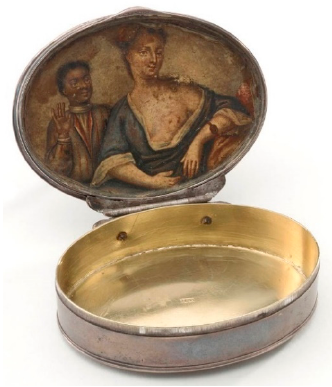
Figure 9. William Hutchinson, snuffbox. Silver glazed, ivory; 24 mm × 75 mm × 58 mm (ZBA2452). National Maritime Museum, Greenwich, London, Michael Graham-Stewart Slavery Collection. © National Maritime Museum, Greenwich, London.